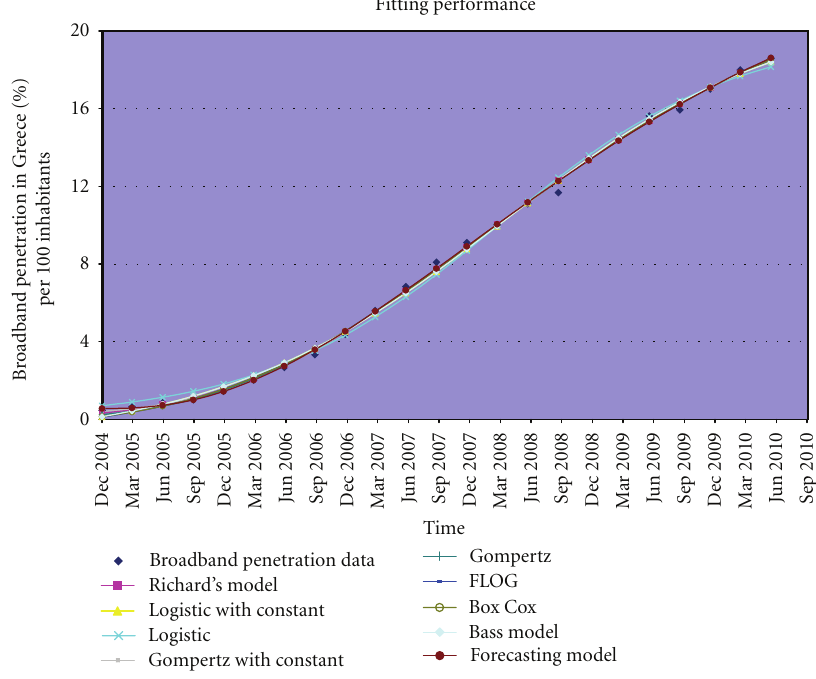
Figure 5: The overall fitting performance of the models.